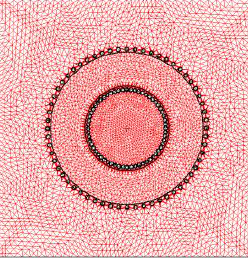
Figure 2. Mesh generated by the simulation program for the domain designed in